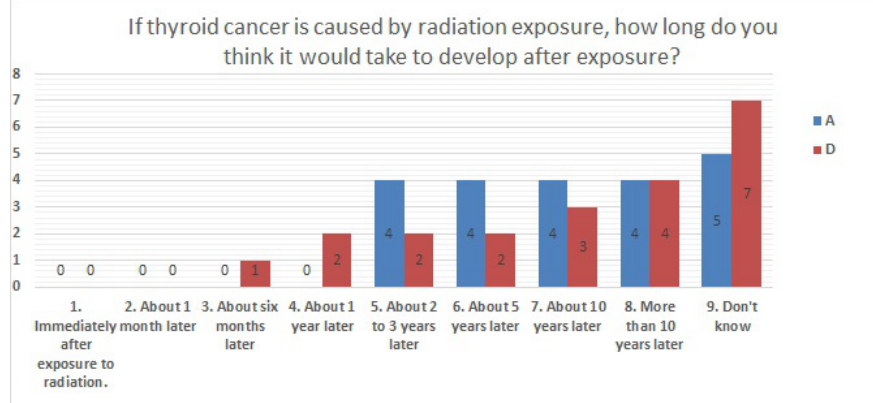
Figure 15. Responses to item No. 14.